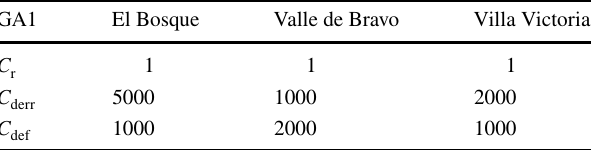
Fig. 4 The Z curve optimized with genetic algorithm GA1 Table 1 The penalty coefficients integrated into genetic algorithm GA1 policy